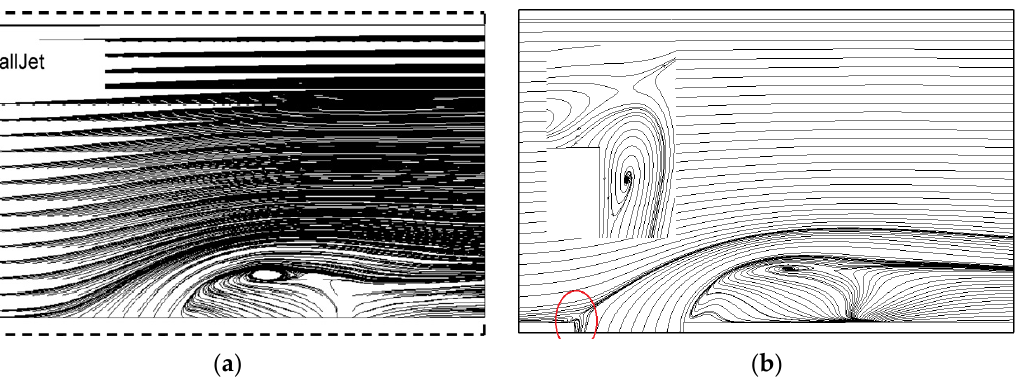
Figure 10. Time-averaged streamlines in y-z plane of W-ref case at X = 0. ( a ) LES results conducted by Kamde et al. [5]; ( b ) ELES results.